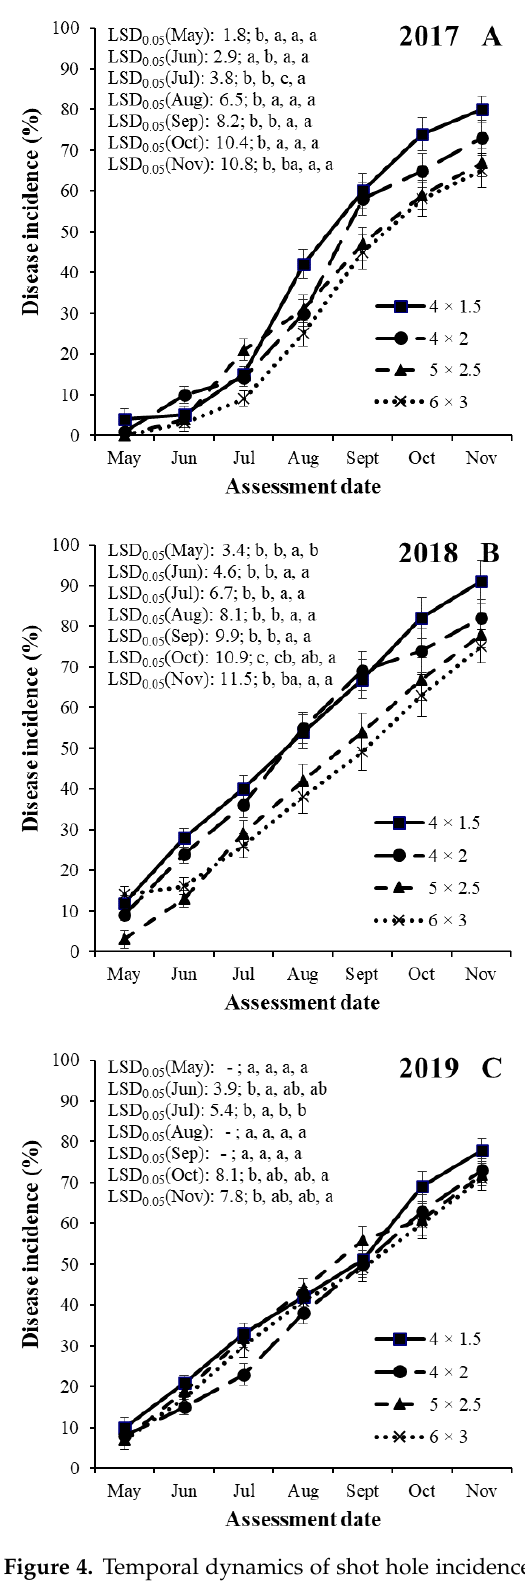
Figure 4. Temporal dynamics of shot hole incidence on plum cultivar ‘President’ in four training systems (4 × 1.5, 4 × 2, 5 × 2.5 and 6 × 3 m) in the years of 2017 ( A ), 2018 ( B ) and 2019 ( C ) at seven assessment dates (May, Jun, Jul, Aug, Sept, Oct and Nov) in an integrated plum orchard at Debrecen-Pallag, Eastern Hungary. Details of explanations on significant symbols and LSD-test are given in Figure